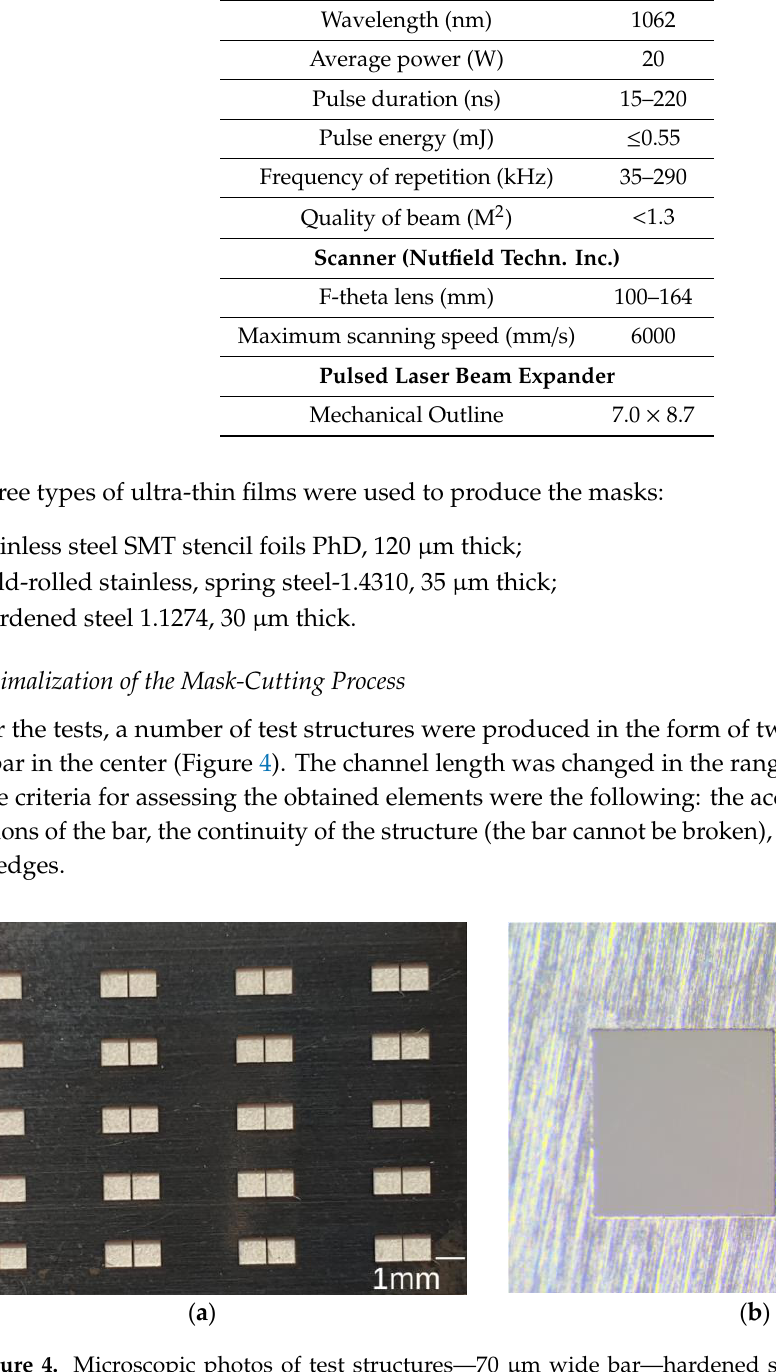
Table 1. Parameters of the devices of the laser system.